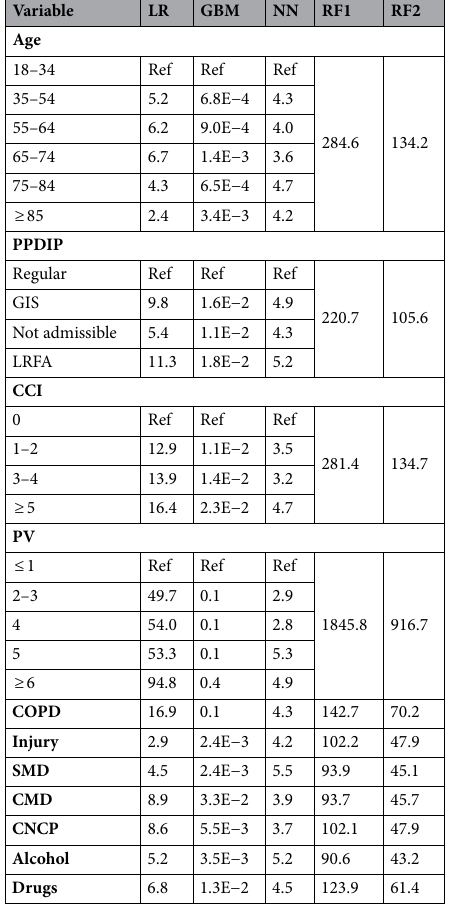
Table 4. Variable importance for the predictive models (frequent users 5). The higher the value, the higher the importance (relative to a model). LR logistic regression, GBM gradient boosting machine, NN neural network, RF random forests (1: binary outcome, 2: continuous